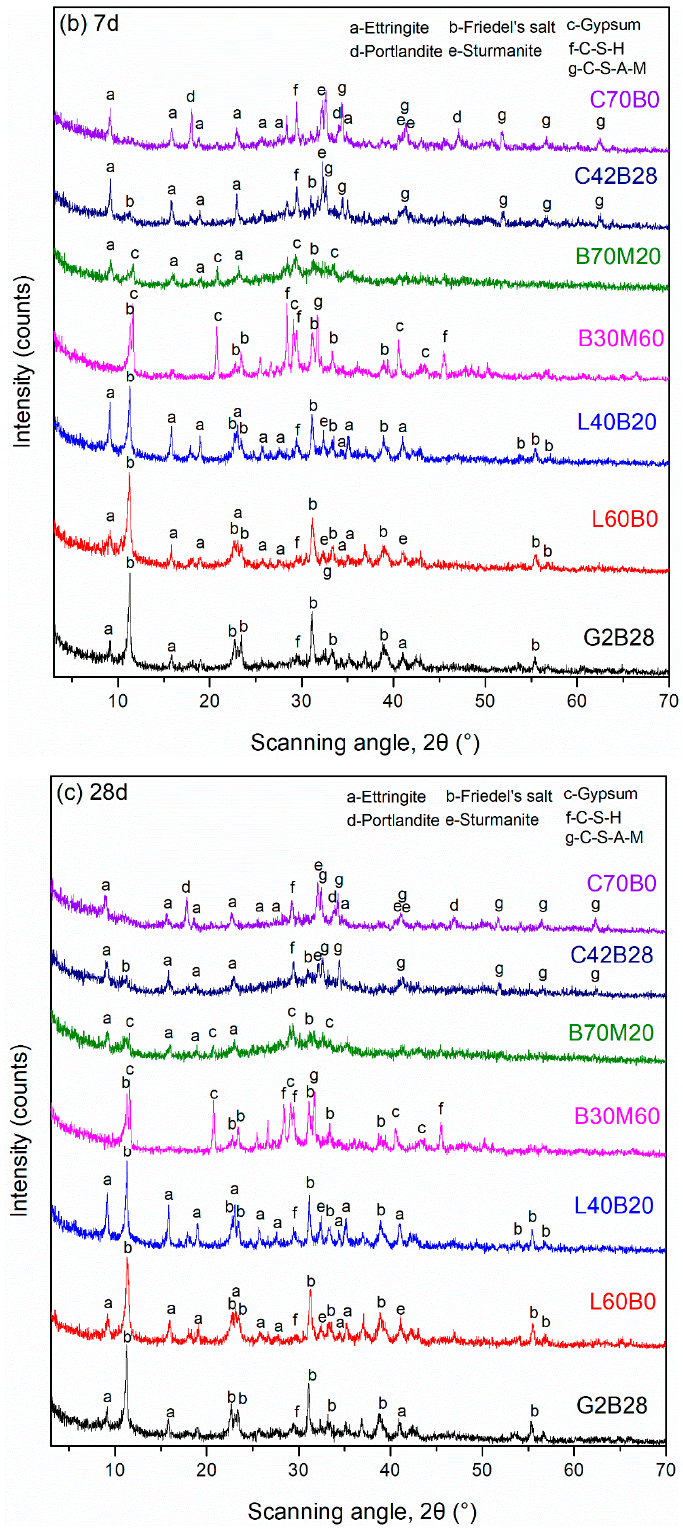
Figure 3. XRD patterns for pastes hydrated for ( a ) 3 days, ( b ) 7 days, and ( c ) 28 days for chosen groups (PDF#: ettringite—41-1451; Friedel’s salt—31-0245; gypsum—21-0816; portlandite—72-0156; sturmanite—35-0637; C-S-H—14-0035; C-A-S-M—13-0272). Table 3. Qualitative changes in amount of hydrates of representative mixtures. The notations are as follows— √ : Is present; ×: Is absent; ↑ : Increases; ↓ : Decreases.